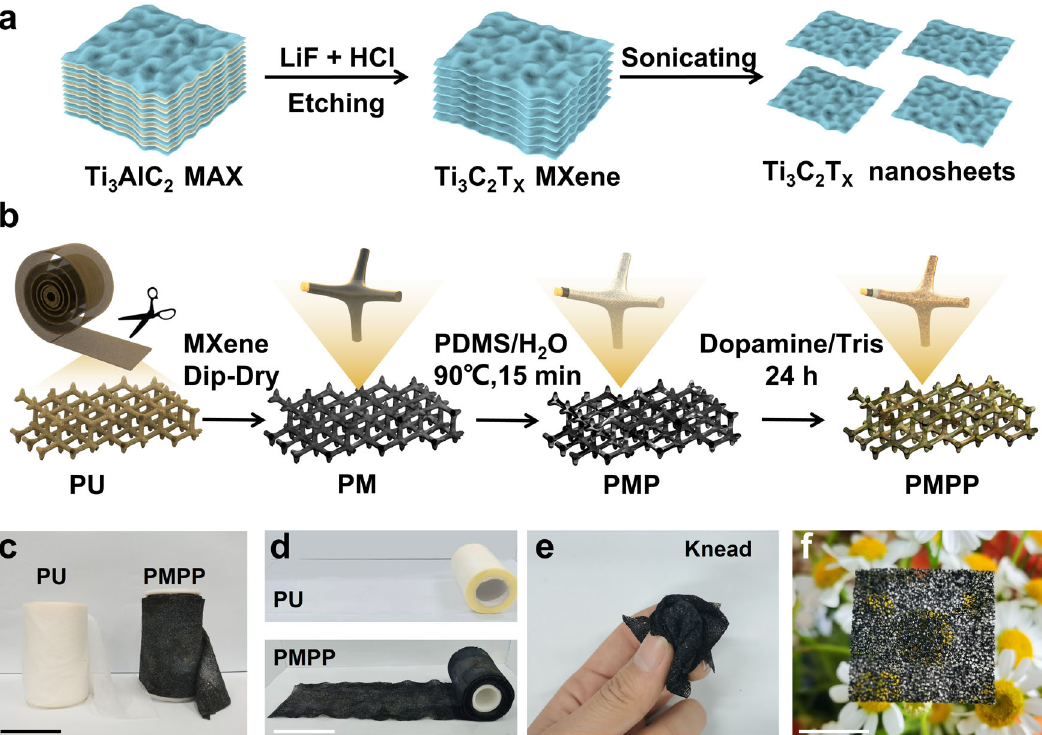
Fig. 1 Scalable manufacturing of breathable PMPP hybrid sponge fi lm. Schematic of preparation process of ( a ) MXene nanosheets and ( b ) MXene-based PMPP breathable sponge fi lm. c , d Digital pictures for spools of PU sponge fi lm and PMPP (Scale bars: 3 cm, 5 cm). e Digital picture of kneaded PMPP. f Digital picture of light, porous and thin PMPP (Scale bars: 1